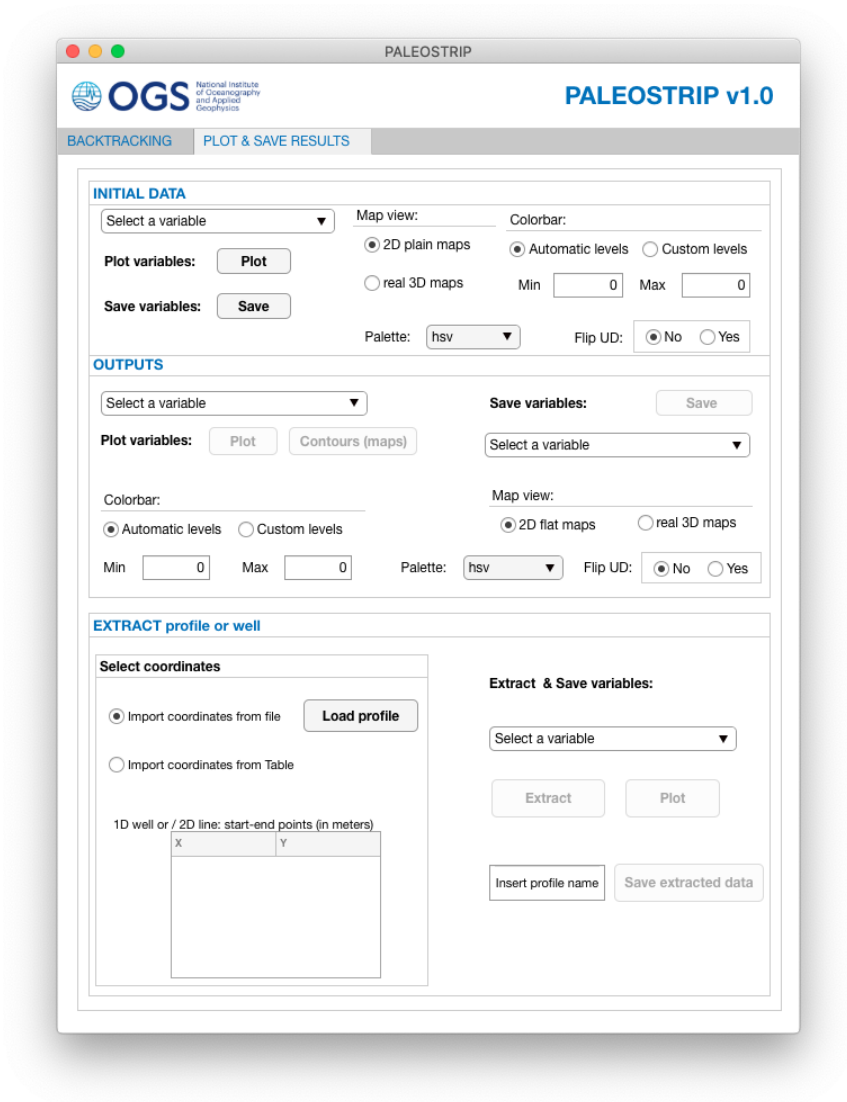
Figure 7. PALEOSTRIP Application GUI plot and save results